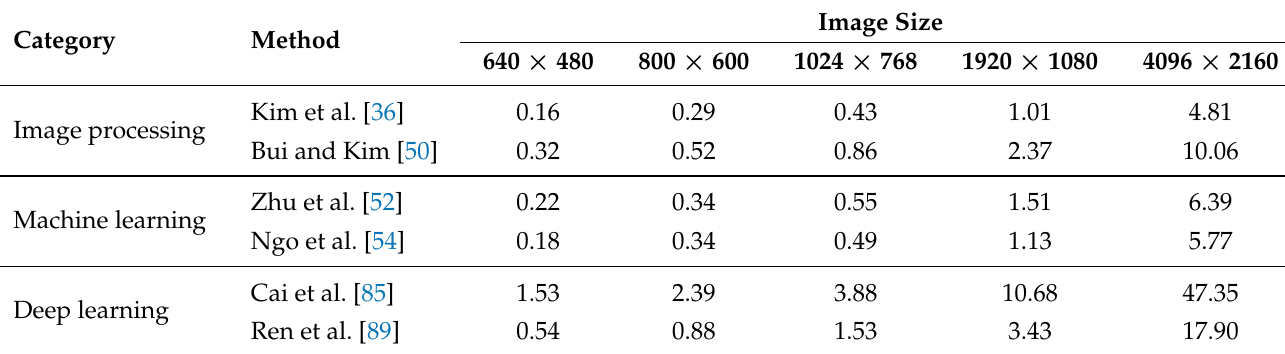
Table 2. Processing time in seconds of different dehazing methods for various image sizes.